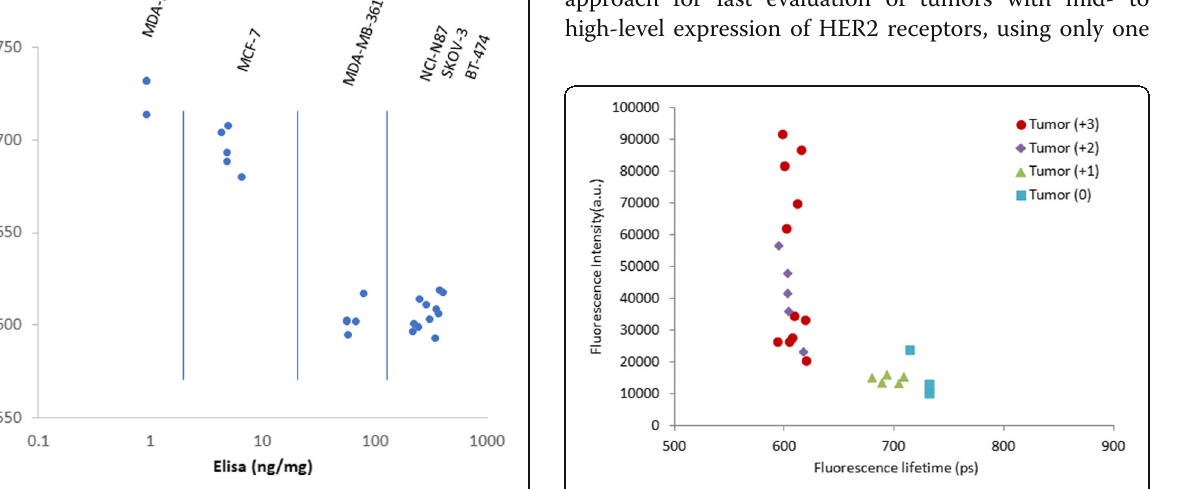
Fig. 4 Fluorescence intensity vs. fluorescence lifetime of all tumors with high- (+3), mid- (+2), low- (+1) level and no (0) HER2